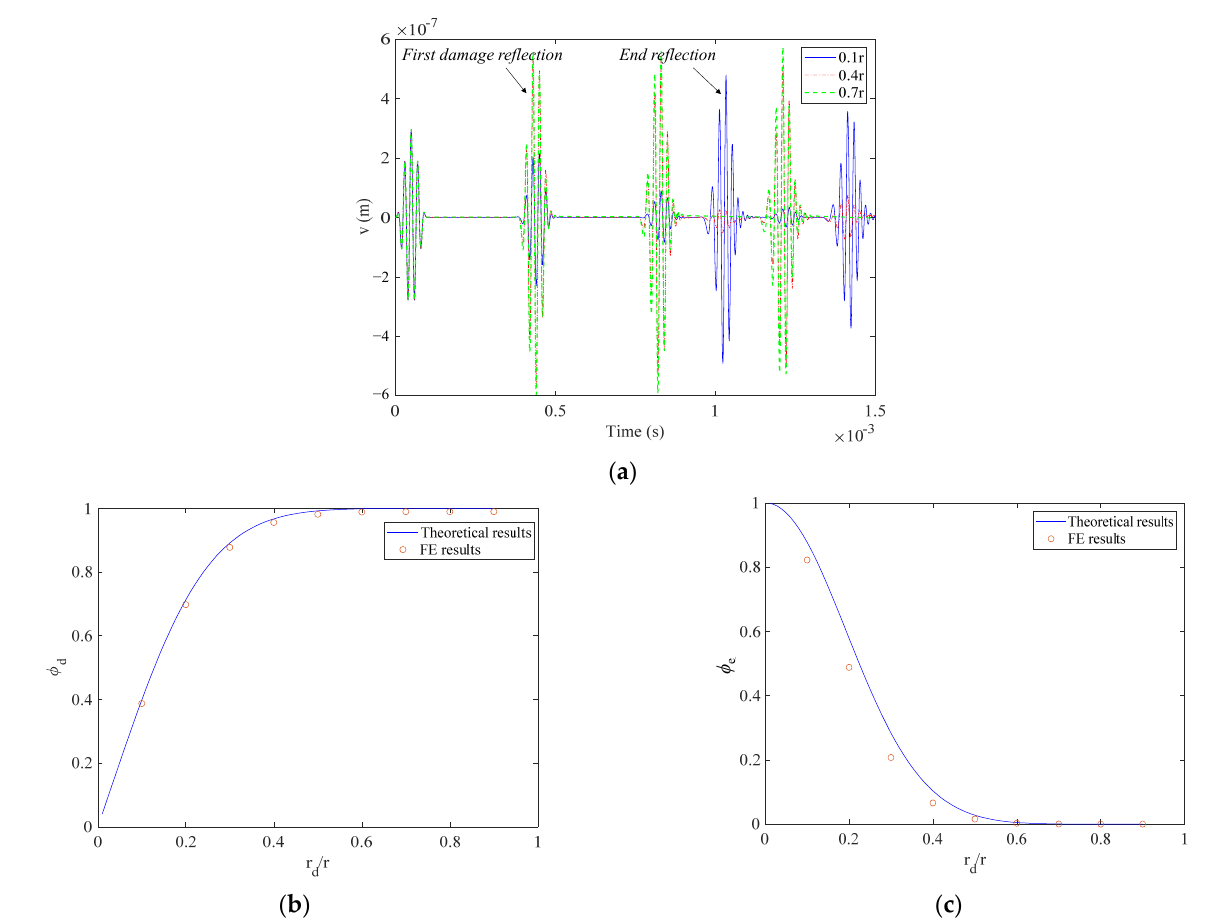
Figure 7. Influence of damage depth on torsional wave reflections: ( a ) typical time-domain signals; ( b ) reflection coefficients from the defect; ( c ) reflection coefficients from the end.